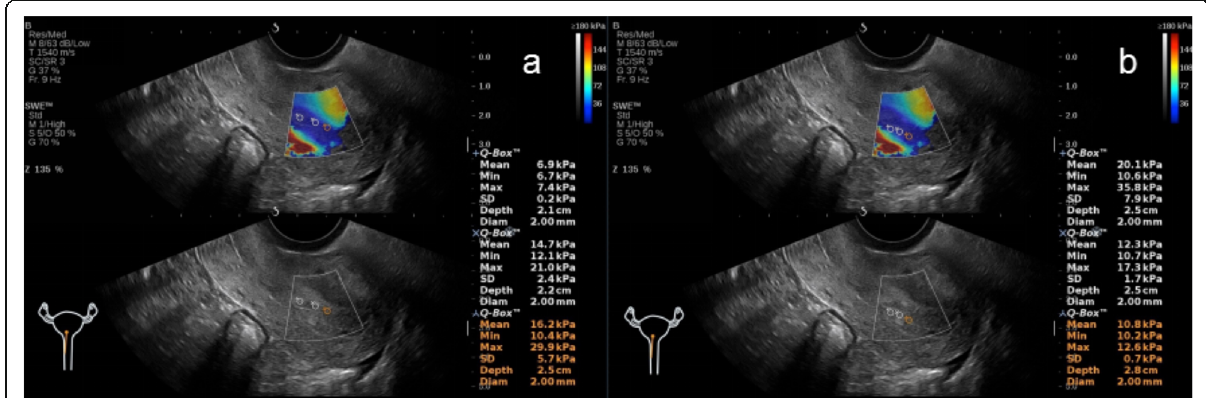
Fig. 4 Representative images of a woman in the AOAA group. a Young ’ s modulus at the three sites of the anterior endometrial wall was 6.9, 14.7, and 16.2 kPa, respectively; b Young ’ s modulus at the three sites of the posterior endometrial wall was 20.1, 12.3, and 10.8 kPa, respectively. The mean Young ’ s modulus of the six sampling sites was 13.5 kPa